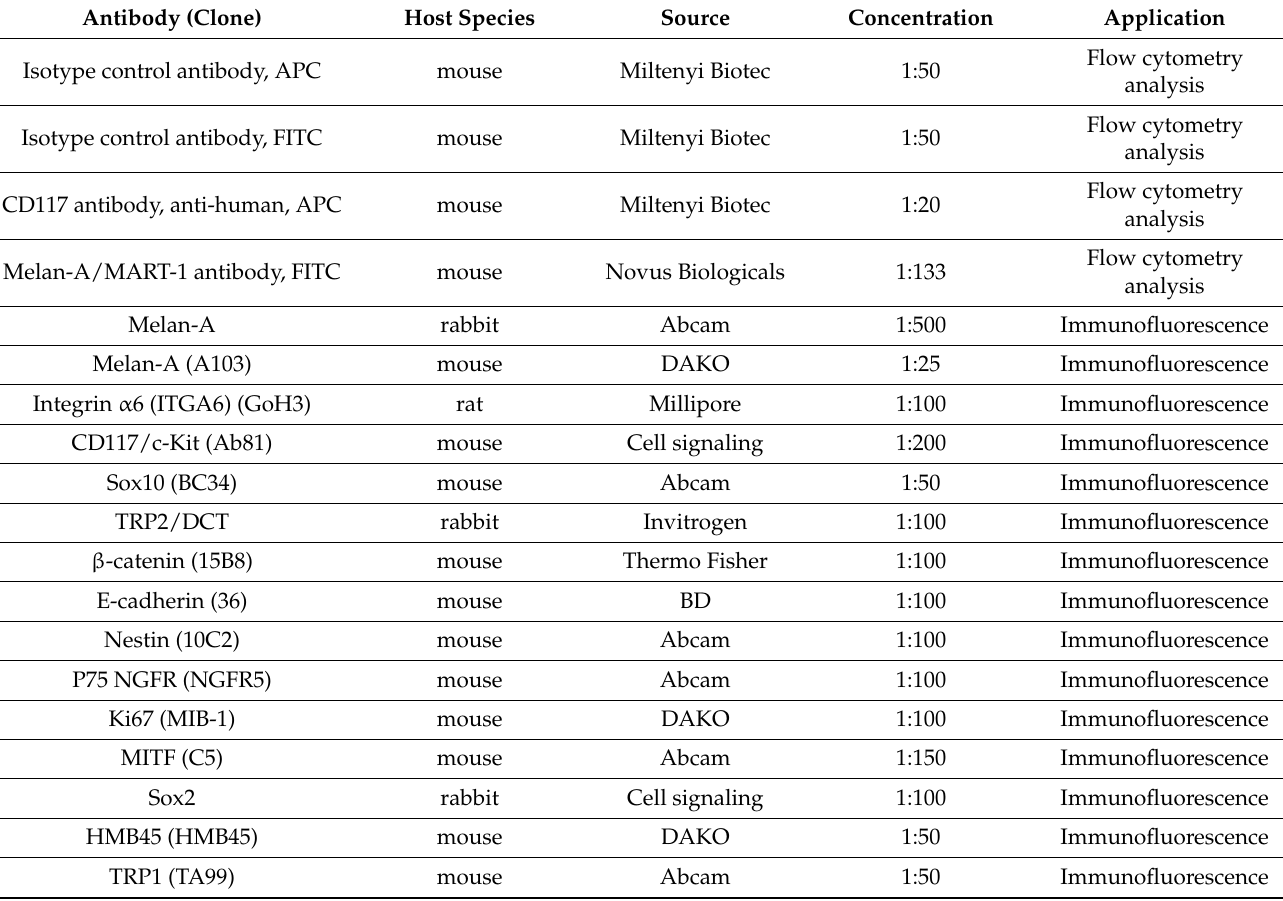
Table 1. List of antibodies used for